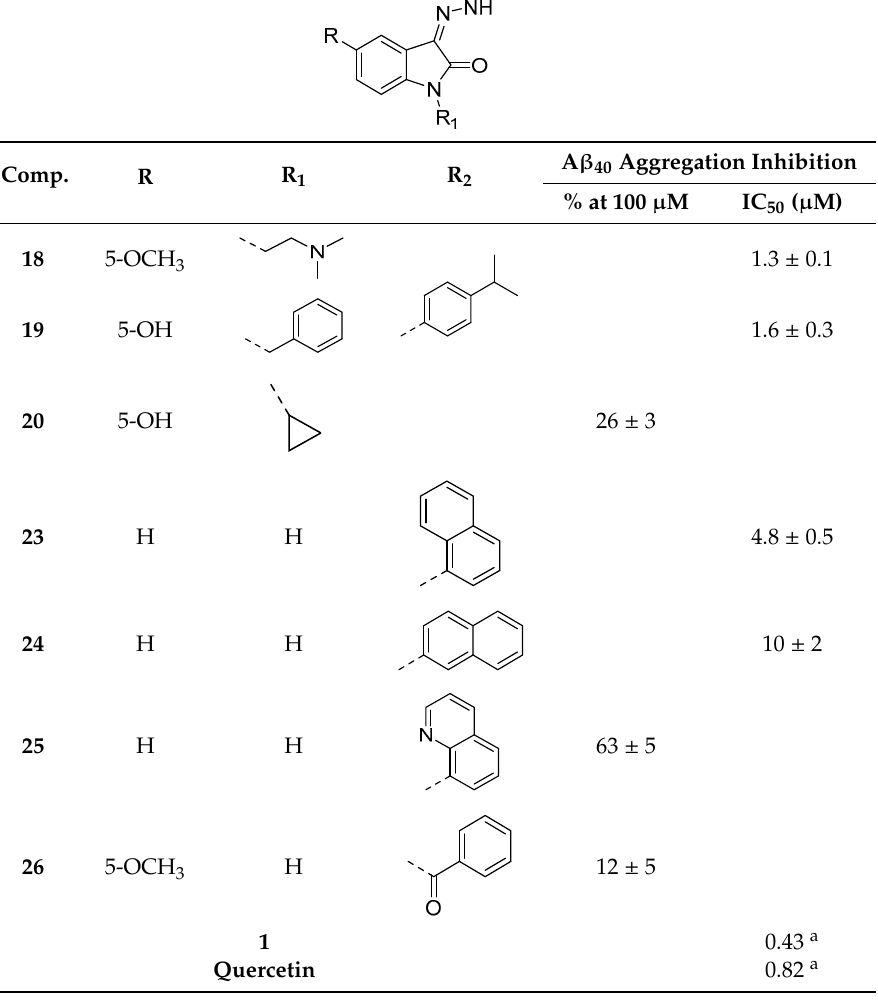
Table 2. Inhibition data of new isatin derivatives 2 , 3 , 10 – 14 , 27 and 44 .